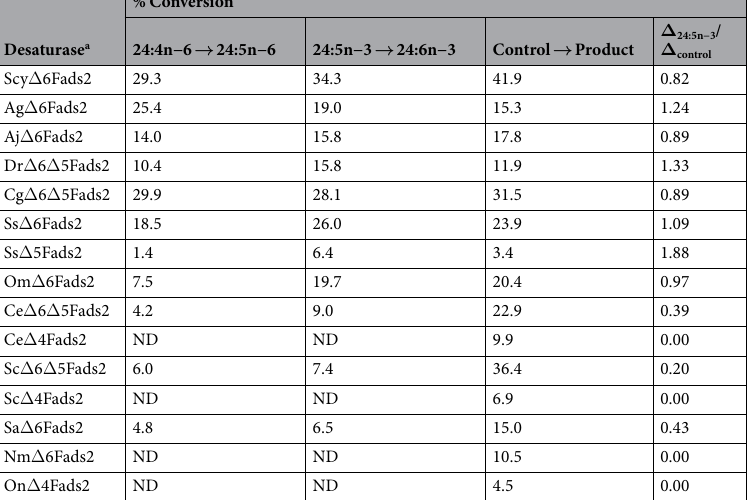
Table 1. Capability of fish Fads2 for Δ 6 desaturation of C 24 substrates 24:4n − 6 and 24:5n − 3 using a yeast Saccharomyces cerevisiae heterologous system as described in Materials and Methods. Fatty acid (FA) conversions were calculated as the percentage of 24:4n − 6 and 24:5n − 3 desaturated to 24:5n − 6 and 24:6n − 3, respectively, as [product area/(product area + substrate area)] × 100. Conversions towards the control FA substrate (18:3n − 3 as controls for Δ 6 and Δ 6 Δ 5 desaturases, 20:4n − 3 for Δ 5 desaturases and 22:5n − 3 for Δ 4 desaturases) are also indicated. In order to normalise the % conversions obtained throughout the Fads2 dataset, ratios between the activities on 24:5n − 3 and those on the control FA (“ Δ 24:5n − 3 / Δ control ”) are also presented. ND, Not detected a Scy, Scyliorhinus canicula; Ag, Arapaima gigas ; Aj, Anguilla japonica ; Dr, Danio rerio ; Cg,